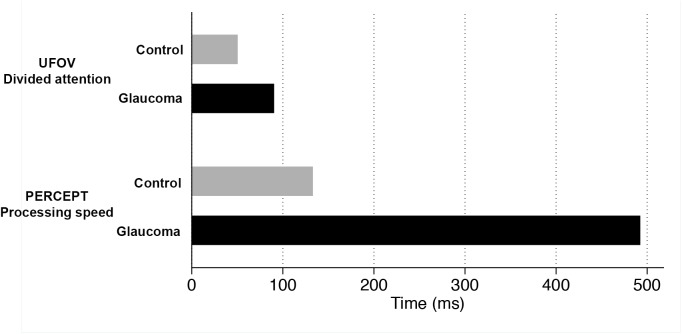
Bar graph illustrating the results of the PERformance CEntered Portable Test processing speed and Useful Field of View divided attention for assessment of visual performance glaucoma and control subjects.